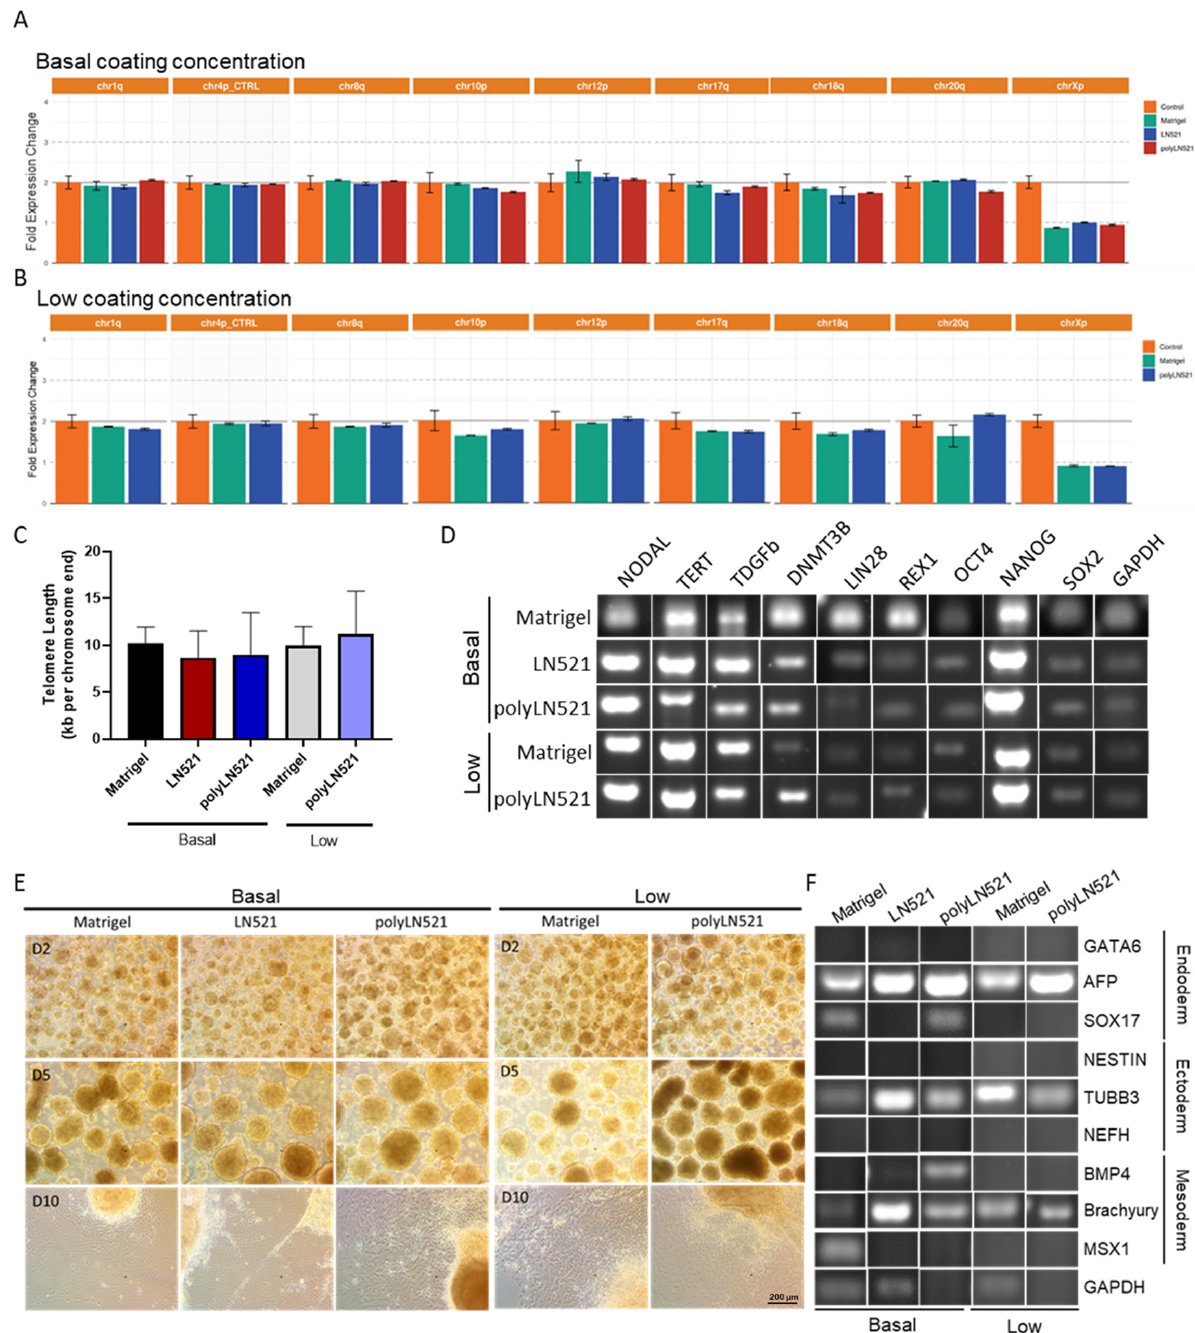
Figure 5. Characterization of pluripotency in human induced pluripotent stem cells (hiPSCs) cul- tivated on polyLN521. ( A , B ) Genetic screening analysis: quantitative PCR (qPCR) for Chr 1q, Chr 4p, Chr 8q, Chr 10p, Chr 12p, Chr 18q, Chr 20q and Chr Xp from cells cultivated on basal-Matrigel, basal-LN521, and basal-polyLN521 (( A ), n = 3) or low-Matrigel, low-LN521, and low-polyLN521 (( B ), n = 3). ( C ) Telomere length of hiPSCs ( n = 4). ( D ) Pluripotent gene expression in